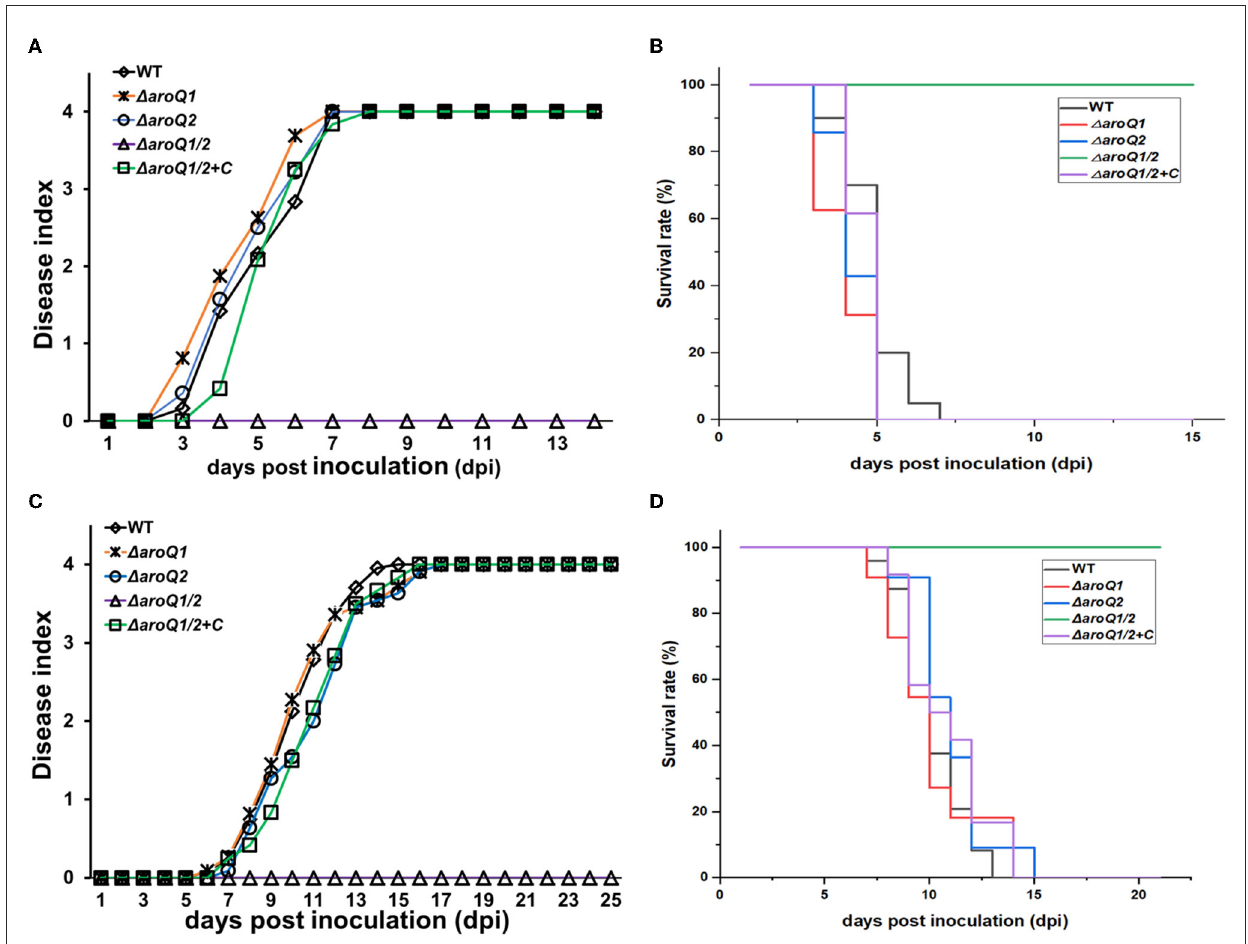
FIGURE5 Virulence of aroQ mutants on (A, B) tomato plants with the petiole-cutting inoculation method (C, D) , tobacco plants with the leaf infiltration method. WT, RK5050 (OE1-1, popA-lacZYA ); 1 aroQ1 , RQ5920 (RK5050, 1 aroQ1 ); 1 aroQ2 , RQ5908 (RK5050, 1 aroQ2 ); 1 aroQ1/2, RQ5951 (RK5050, 1 aroQ1/2 ); 1 aroQ1/2 + C, and RQC1634 (RQ5951 with complementary aroQ1 ). (A, C) Refer to virulence assay with the disease index. (B, D) Refer to surviving curves corresponding to the virulence test with the disease index of (A, B) , respectively. For the petiole-cutting inoculation, 2 µ l of a bacterial suspension at 10 8 CFU ml − 1 was dropped onto the freshly cut surface of tomato petioles. For the leaf infiltration, about 50 µ l of the bacterial suspension of 10 8 CFU ml − 1 was infiltrated into the tobacco leaves with a blunt-end syringe. For the disease index, wilt symptoms on test plants were scored on a disease index scale from 0 to 4 (0, no wilting; 1, 1–25% wilting; 2, 26–50% wilting; 3, 51–75% wilting; 4, 76–100% wilted and dead). Surviving curves were recorded with two levels of no wilting symptoms (disease index below 3) and completely wilted (disease index equal to or higher than 3) as previously described. Mean values of all experiments were averaged with SD, while it was not presented in figures due to the consideration of esthetic appearance. Statistical significance was assessed using a post-hoc Dunnett’s test following